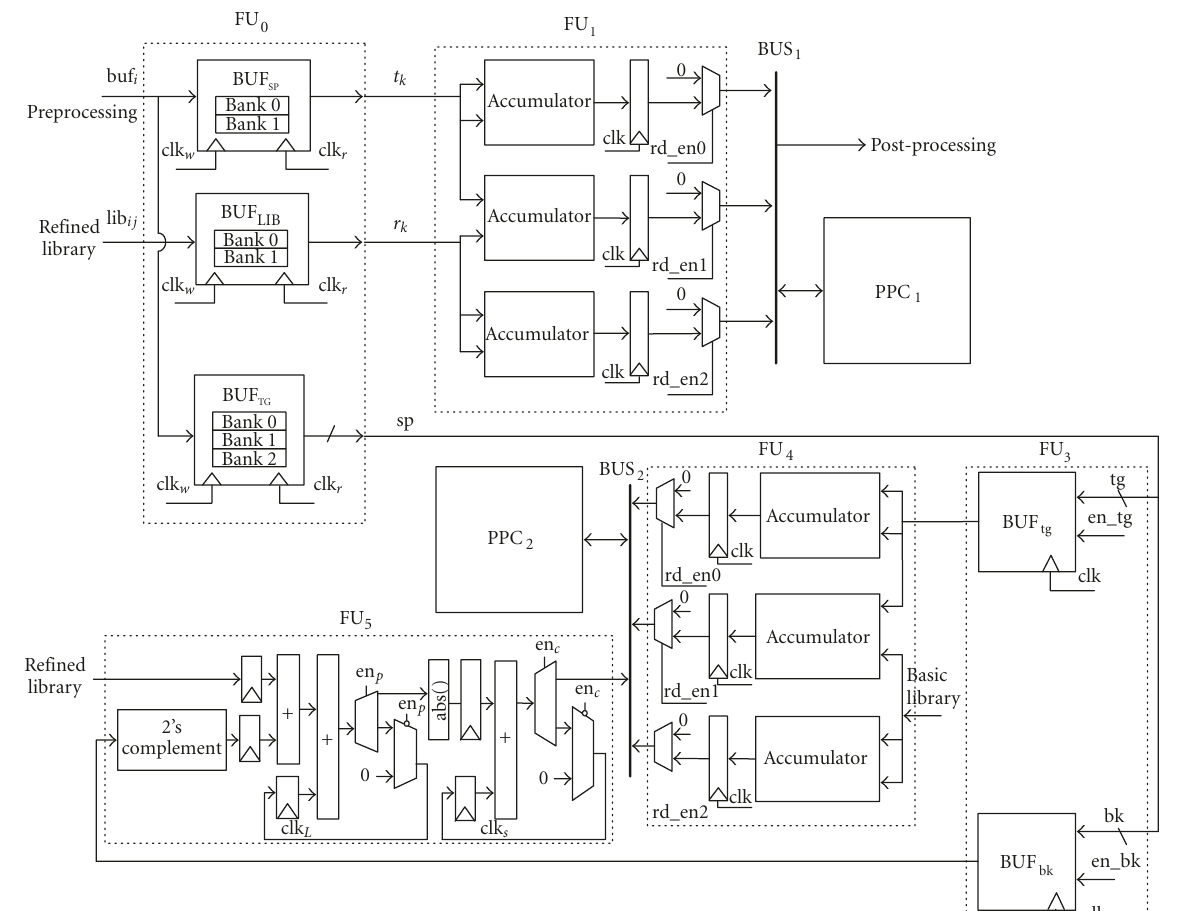
Figure 16: Illustration of a block diagram of a functional unit.